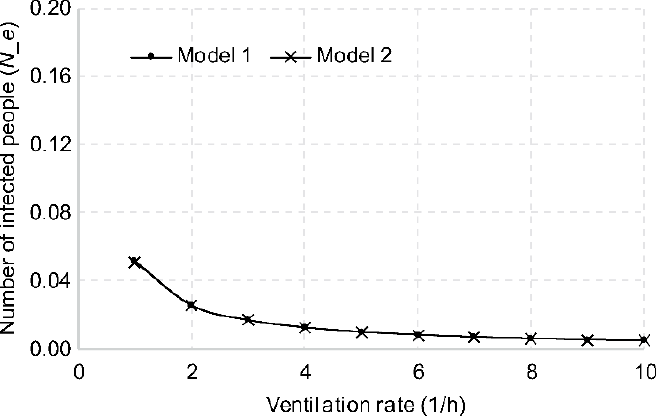
Figure 4. Changes in the number of new infections based on ventilation rate.